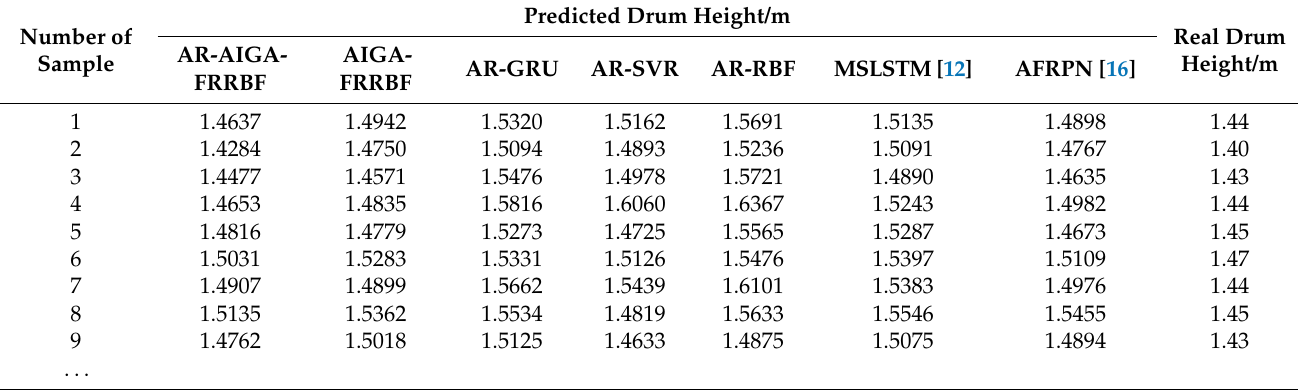
Table 10. Predicted height of the training sample of the left drum of the shearer.